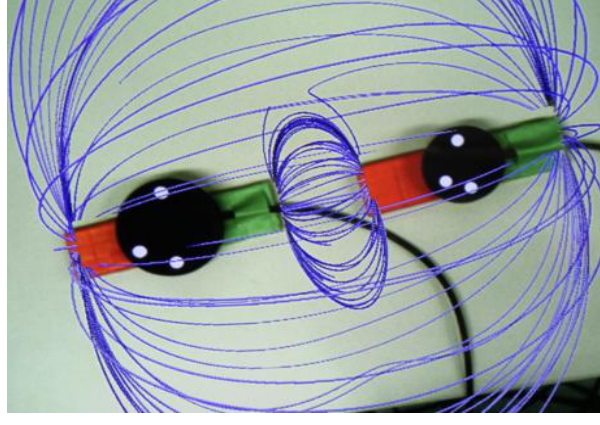
Figure 6. EXAR: Overlay